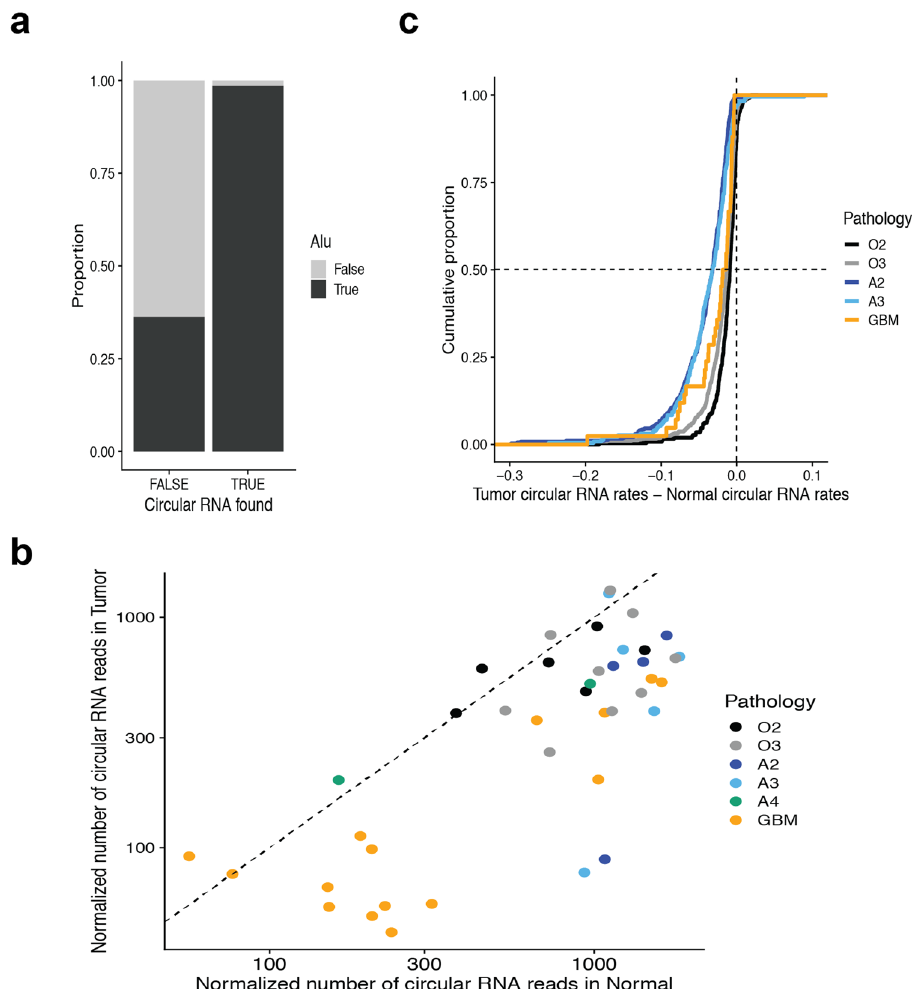
Fig. 2 Circular RNA expression in glioma. a Differences of Alu association with gene bodies between the two gene groups with and without circular RNA- supporting RNA-seq reads (back-splicing junction reads). b The number of circular RNA-supporting reads per one million reads in RNA-seq. The numbers were plotted for individual patients (dots) and tumor and normal tissues (y and x axis values respectively) according to different pathologies (colors): grade 2 oligodendroglioma IDH mutant and 1p/19q-codeleted (O2), grade 3 oligodendroglioma IDH mutant and 1p/19q-codeleted (O3), grade 2 IDH mutant astrocytoma (A2), grade 3 IDH mutant astrocytoma (A3), and glioblastoma (GBM). c Distributions of circular RNA expression rate changes in tumors relative to matched normal tissues were described in a cumulative way for different pathologies: the shift of the curve to the left to 0 means overall decrease in tumor relative to normal